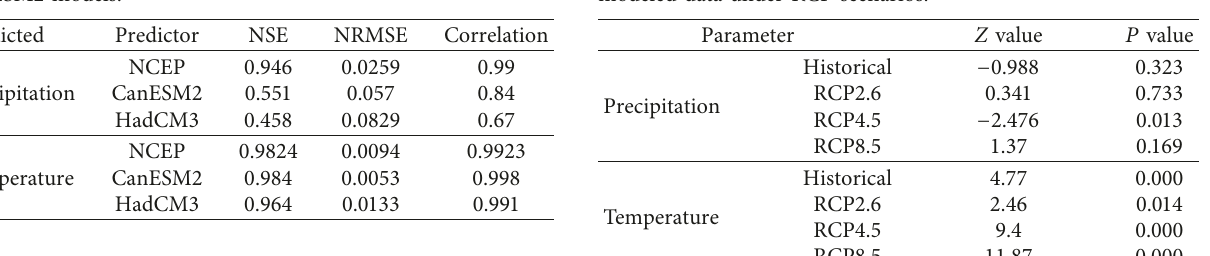
Figure 2: Comparison of downscaled data using predictor variables (NCEP and GCM models) with the historical precipitation and temperature for (a) 1961–2001 (HadCM3) and (b) 1961–2005 (CanESM2). Table 5: Evaluation criteria of downscaled data for HadCM3 and CanESM2 models.